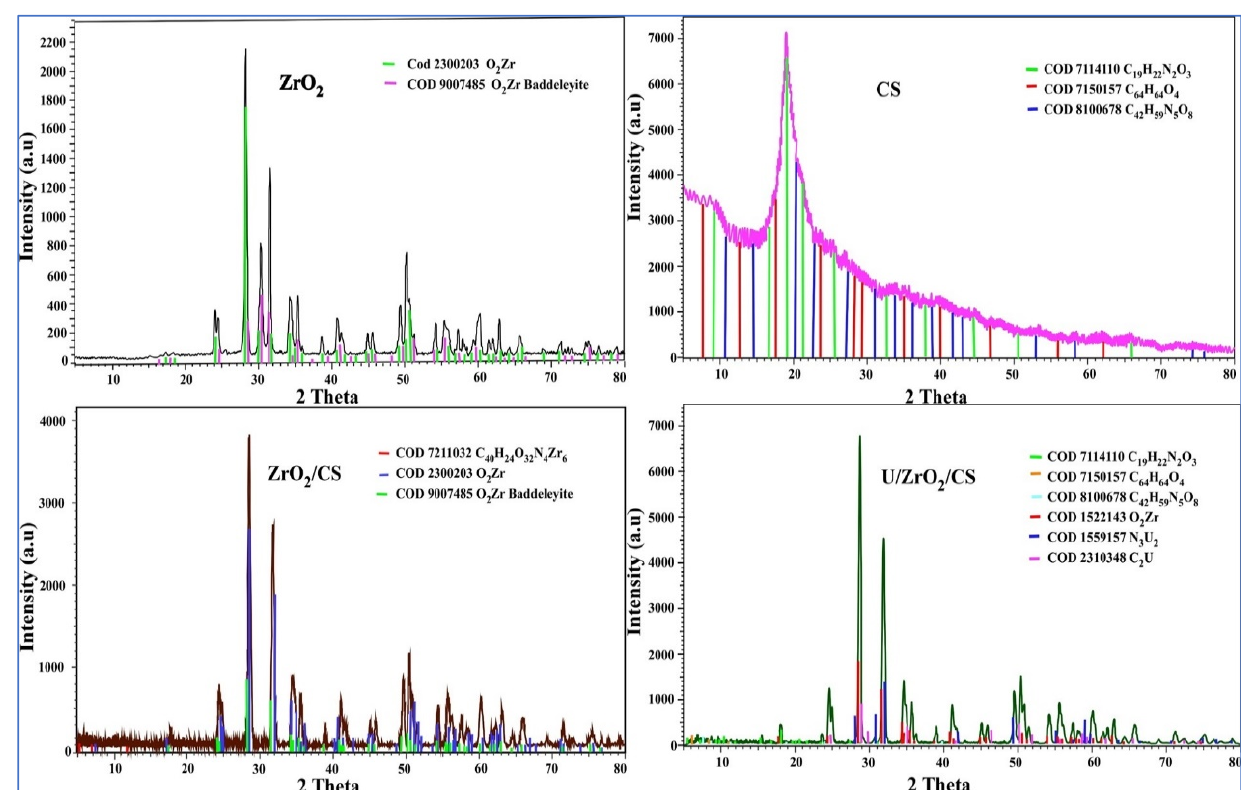
Figure 1. XRD patterns of nano-ZrO 2 , CS, ZrO 2 /CS, and U/ZrO 2